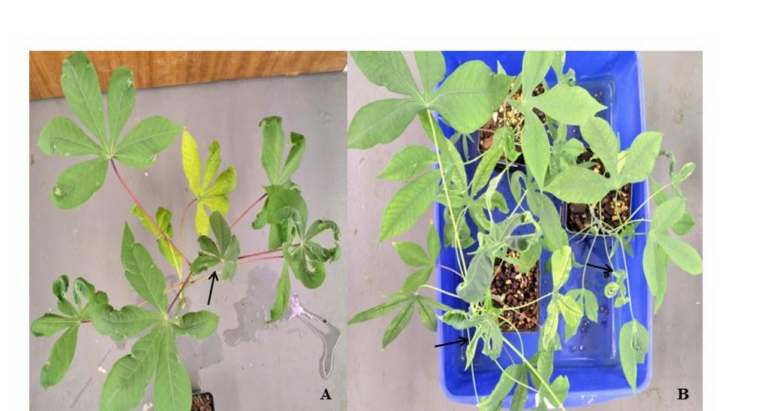
Figure 1. ( A ) Recovery leading to no or milder symptoms in emerging apical leaves (arrow) in CMD-tolerant TME3 ( B ) T200 exhibiting severe symptoms persist